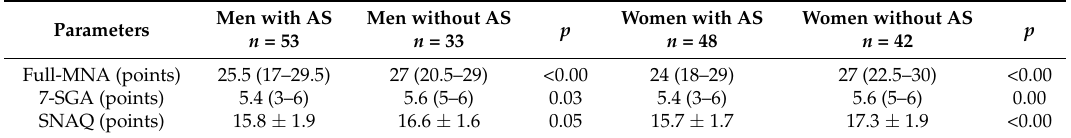
Table 2. Results of nutritional status and appetite assessment. Data are presented as mean ± SD or range.